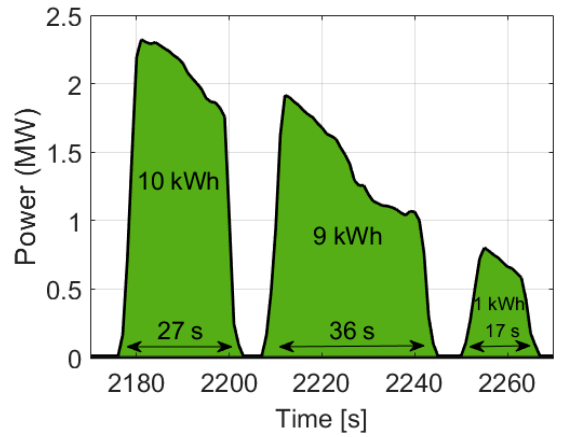
Figure 2. Braking power along the line Bologna–Rimini.